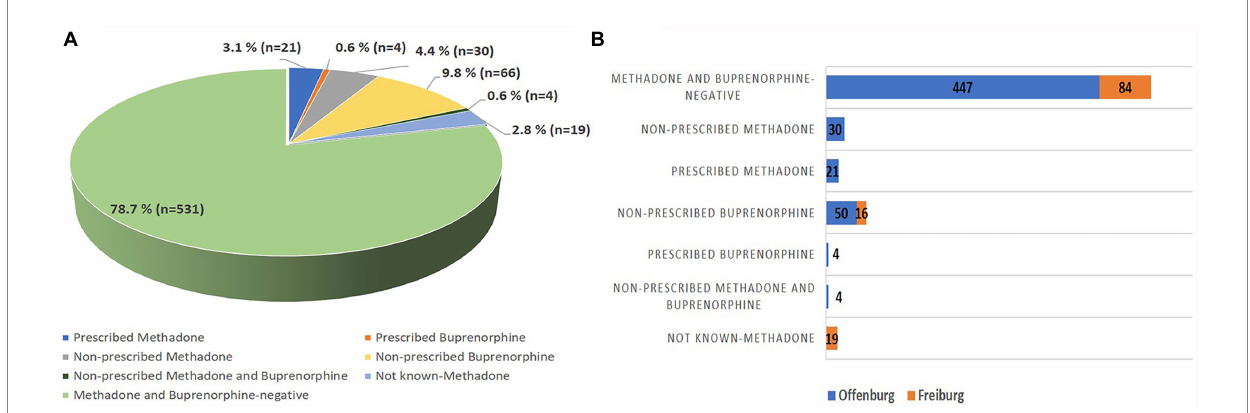
FIGURE 2 Type of OST drug use in the prison population investigated in total (A) and, separated by prison (B) . (A) Out of 675 tested samples, 21 samples (3.1%) were associated with prescribed-methadone, 30 samples (4.4%) were associated with non-prescribed methadone, 4 samples (0.6%) were associated with prescribed-buprenorphine, 66 samples (9.8%) were associated with non-prescribed buprenorphine, 4 samples (0.6%) were associated with non- prescribed combined use of methadone and buprenorphine, 19 samples (2.8%) were not attributable to prescribed or non-prescribed methadone, and 531 (78.7%) samples tested negative for methadone and buprenorphine. (B) Out of the 556 samples tested in the Offenburg prison, 21 samples (3.8%) were associated with prescribed-methadone, 30 samples (5.4%) were associated with non-prescribed methadone, 4 samples (0.7%) were associated with prescribed-buprenorphine, 50 samples (9%) were associated with non-prescribed buprenorphine, 4 samples (0.7%) were associated with non- prescribed combined use of methadone and buprenorphine, and 447 samples (80.4%) tested negative for methadone and buprenorphine. Out of the 119 samples tested in the Freiburg prison, 19 samples (16%) were not attributable to prescribed or non-prescribed methadone, 16 (13.4%) samples were associated with non-prescribed buprenorphine, 84 samples (70.6%) tested negative for methadone, and